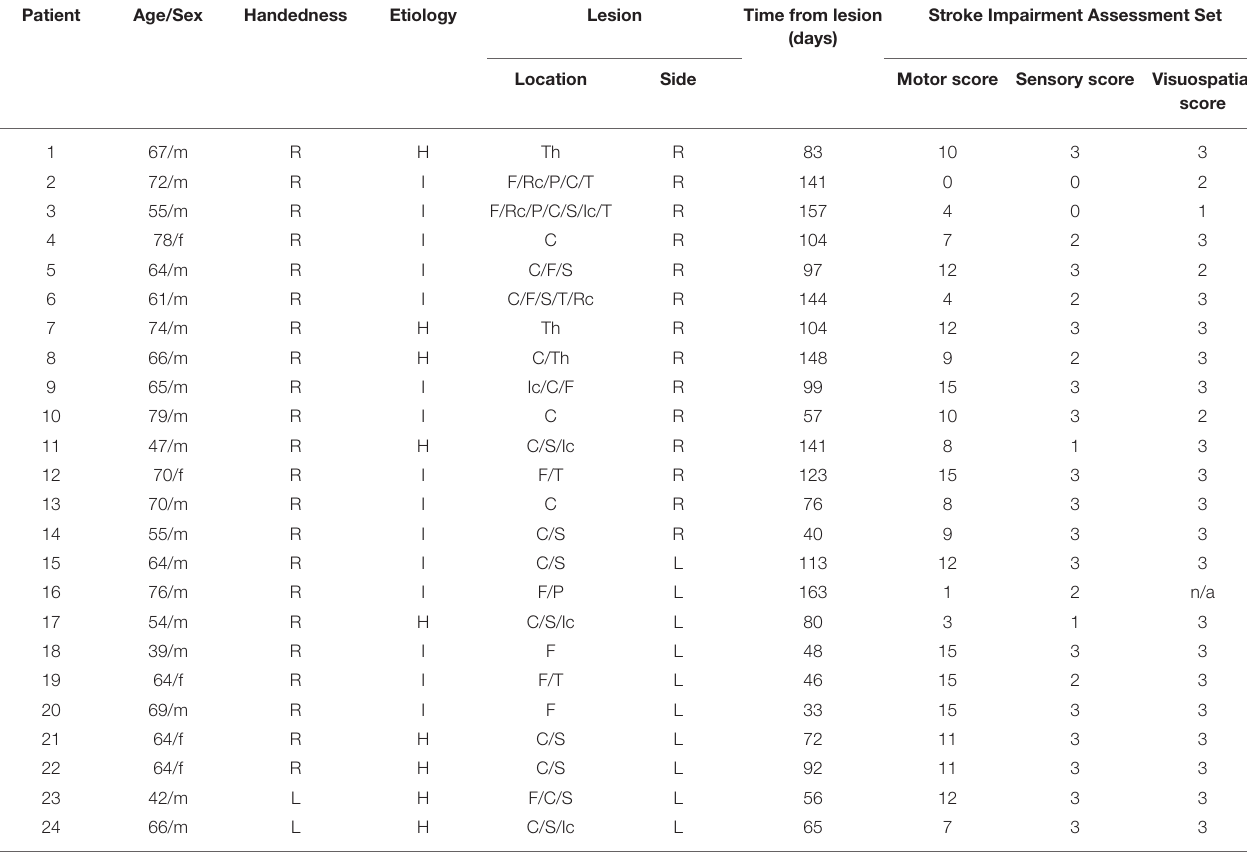
TABLE 1 | Characteristics of the patients with stroke. Patient Age/Sex Handedness Etiology Lesion Time from lesion